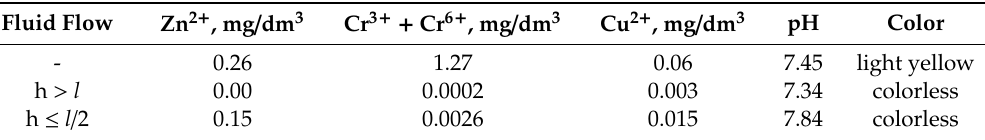
Table 7. The e ff ectiveness of galvanic wastewater purification with changing the scheme of fluid flow